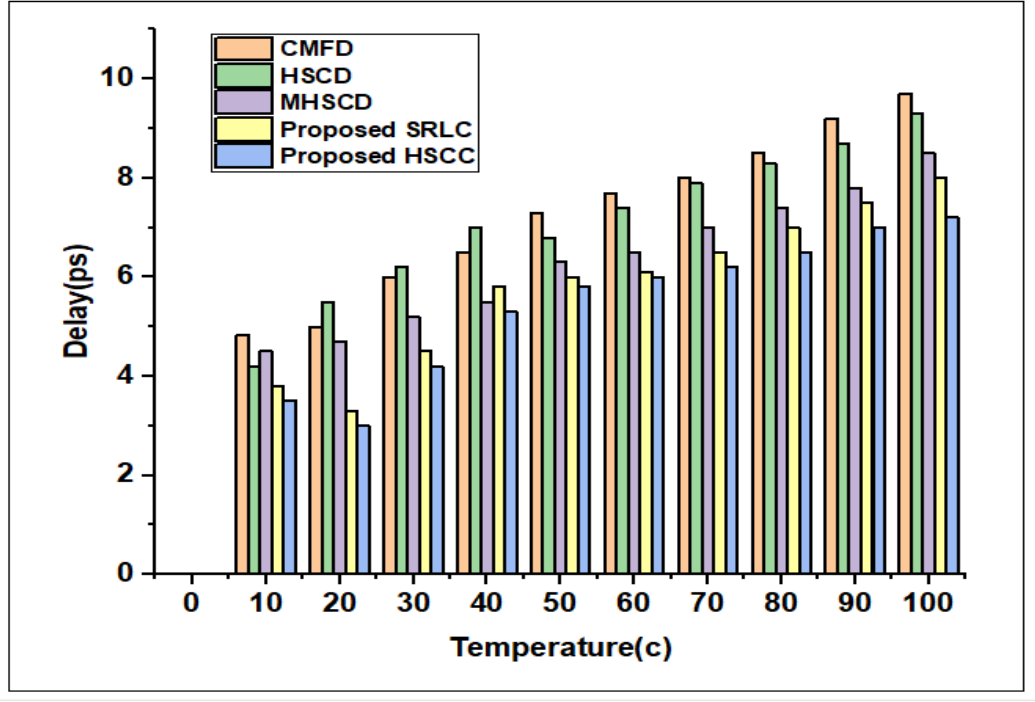
Figure 16. Simulation of delay with the temperature of FinFET-based circuits at 7 nm.